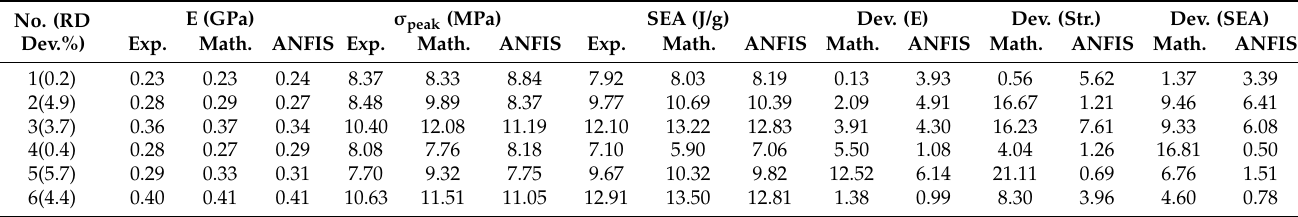
Table 12. Experimental and predicted results of the testing data sets.